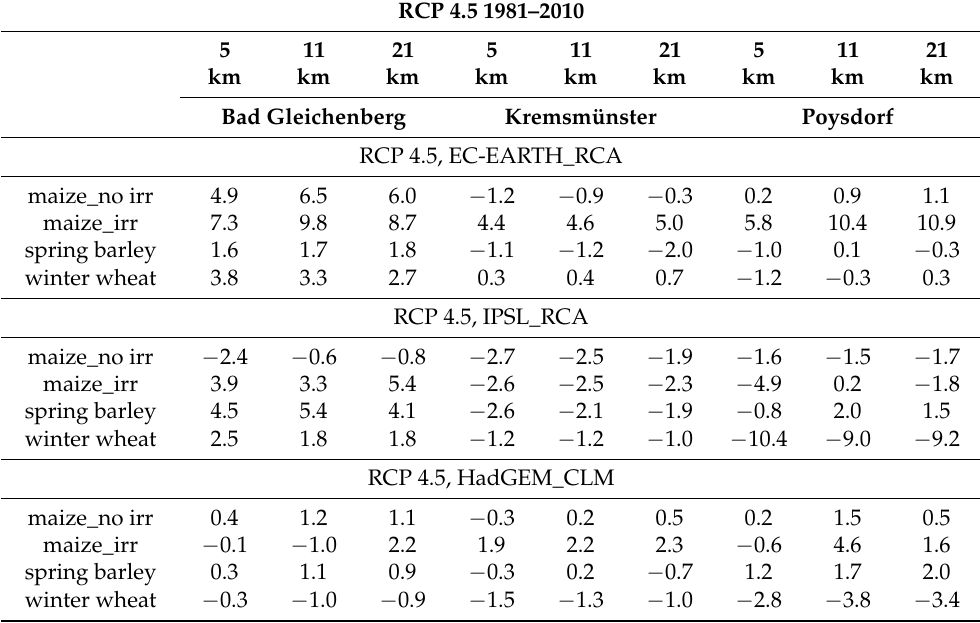
Table 6. Yield differences (%) for maize (rainfed = no irr, optimally irrigated = irr), winter wheat, and spring barley (rainfed) grown on the sandy soil class 1; 1 km input data vs. 5, 11, and 21 km aggregated Gleichenberg, Kremsmünster, and Poysdorf for the 1981–2010 period. Differences in percentage compared with the results with a 1 km